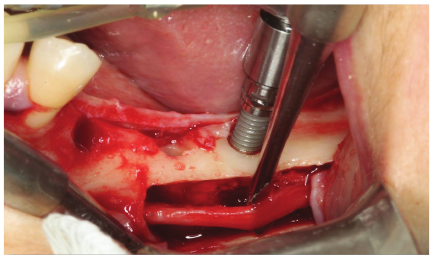
Figure 19: Placing the absorbable membrane.